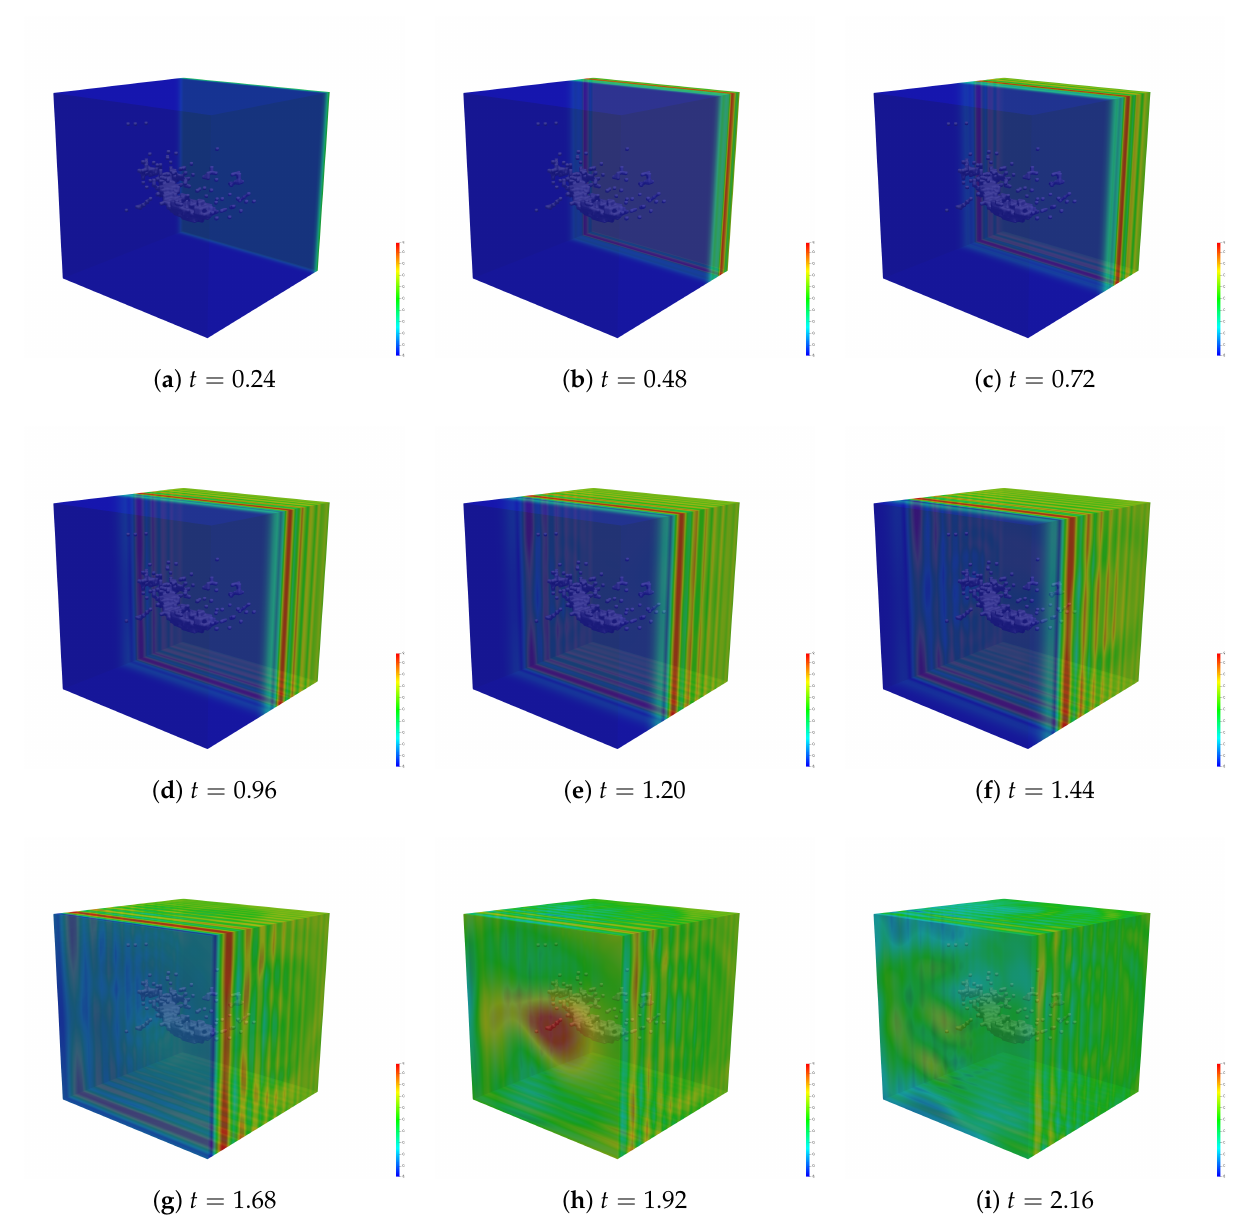
Figure 10. The figures ( a – i ) illustrate how our planar wave f used in implementations propagates through the medium by color plotting